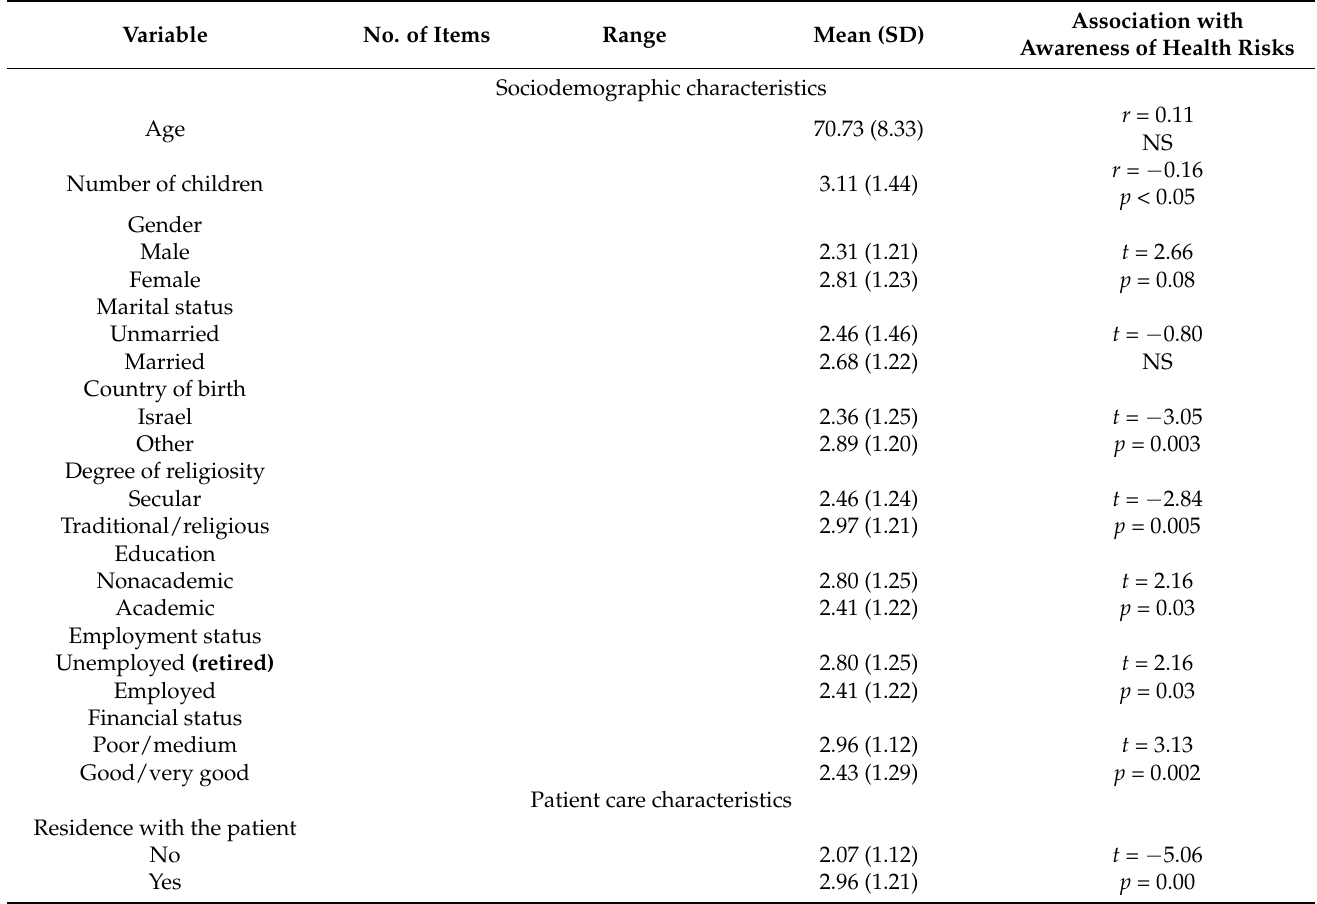
Table 2. Associations between all independent variables in three domains (sociodemographic charac- teristics, patient care characteristics, and situational variables) and level of awareness of health risks, using bivariate analyses according to variable scale structure ( n =